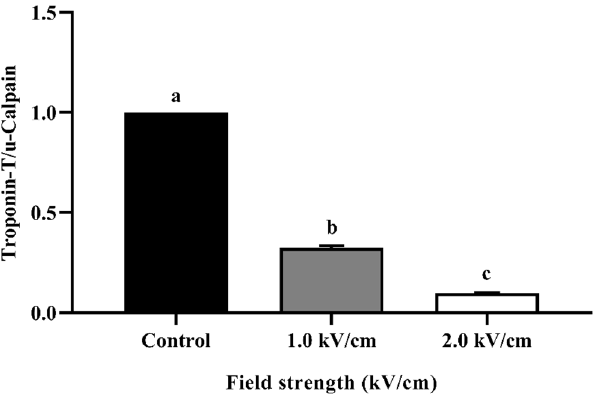
Figure 4. Relative quantification of Western blot for PEF-treated beef with different field strengths. Error bars indicate the standard deviation of six replications ( n = 6). Different letters indicate a significant difference ( p < 0.05).